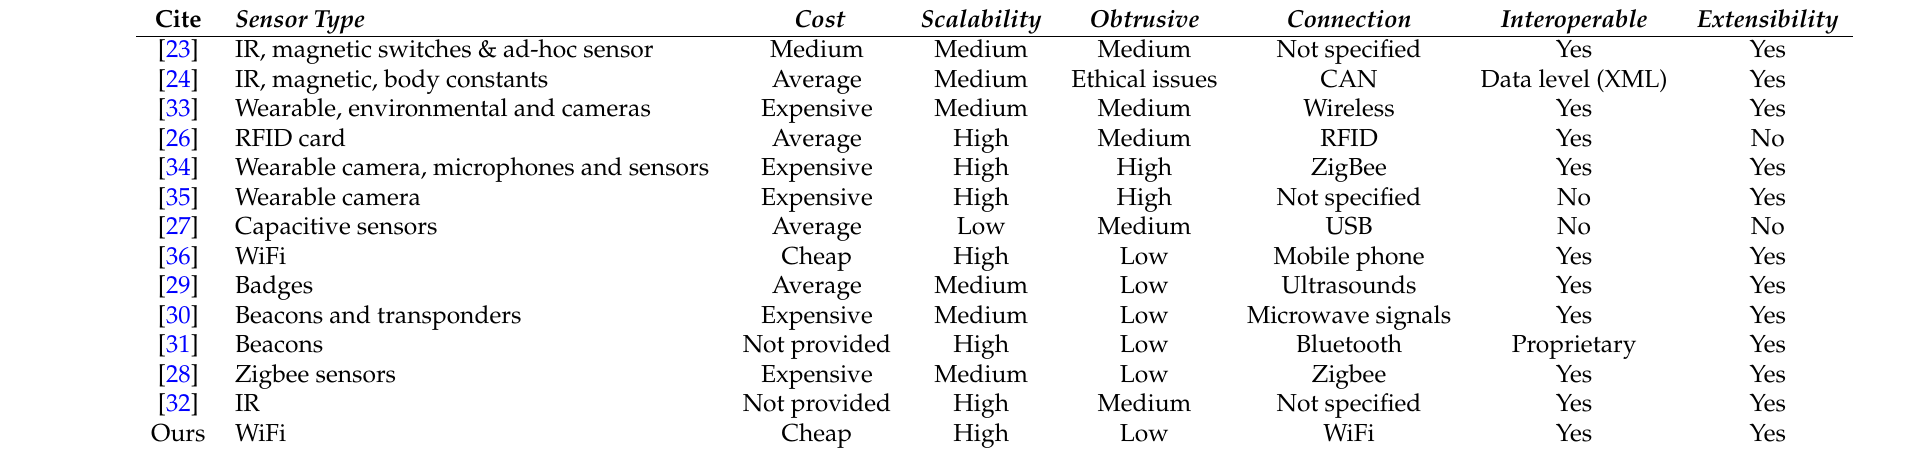
Table 1. In home monitoring systems